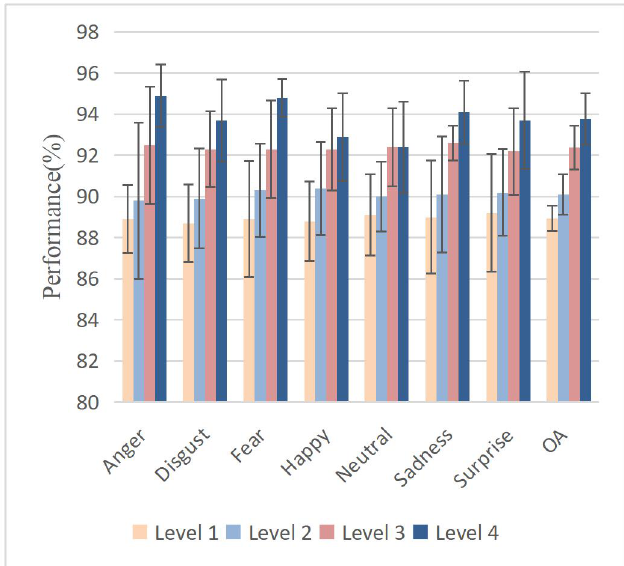
Figure 10. Error bar of different decomposition level